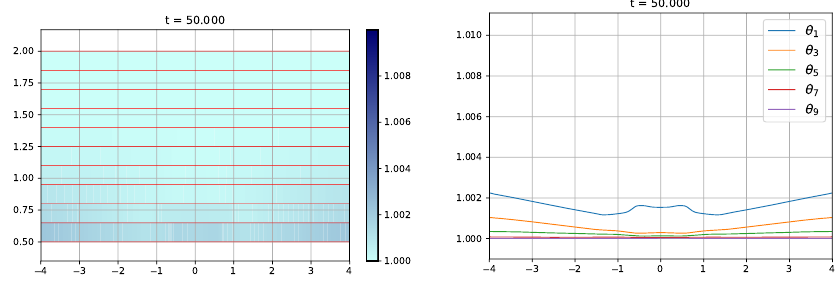
Figure 17. Evolution of the relative density at t = 50 s.